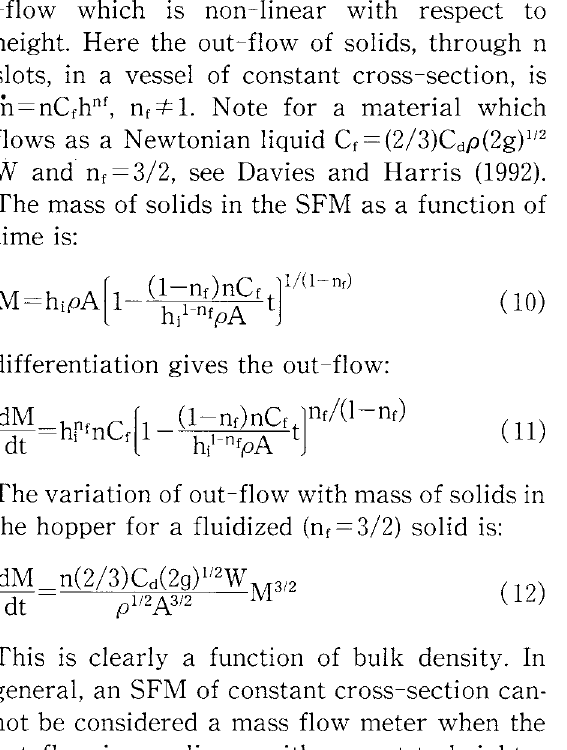
Fig. 8 Calibration curve for 0.2m diameter SFM with FCC : comparison of dynamic (solid line, dM/dt against M) and bucket and watch (::) techniques, Harris